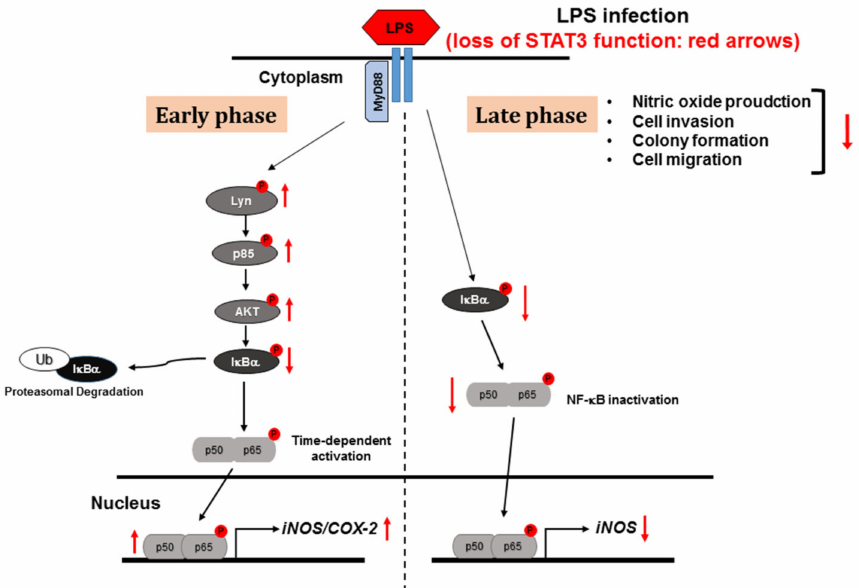
Figure 5. Schematic of inflammatory signaling mechanisms and regulation of STAT3KO macrophages during early and late phases of LPS